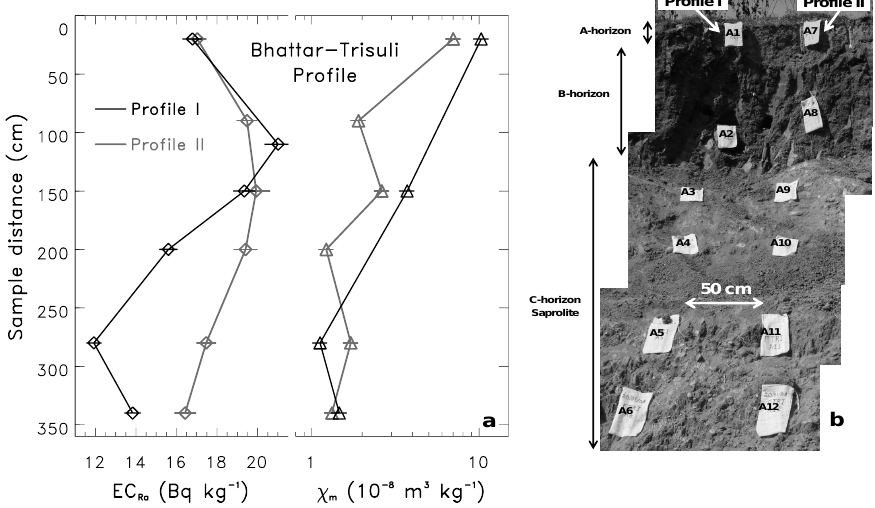
Fig. 3. (a) Vertical profiles of χ m and EC Ra along a scarp of the Bhattar-Trisuli terrace, Nepal (Girault et al., 2011). A view of the scarp is shown in (b) .